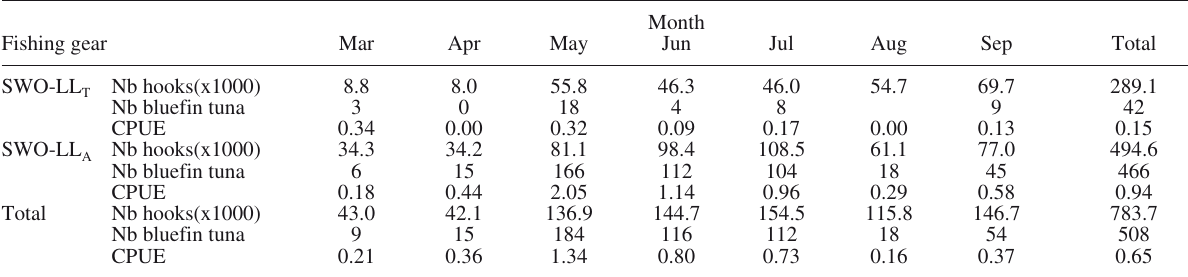
Table 4. – Effort (Nb of hooks), fish captured, and nominal CPUE values (number of fish/1000 hooks) by fishing gear and month for bluefin tunas caught in the eastern Mediterranean Sea swordfish long-line fishery during the period